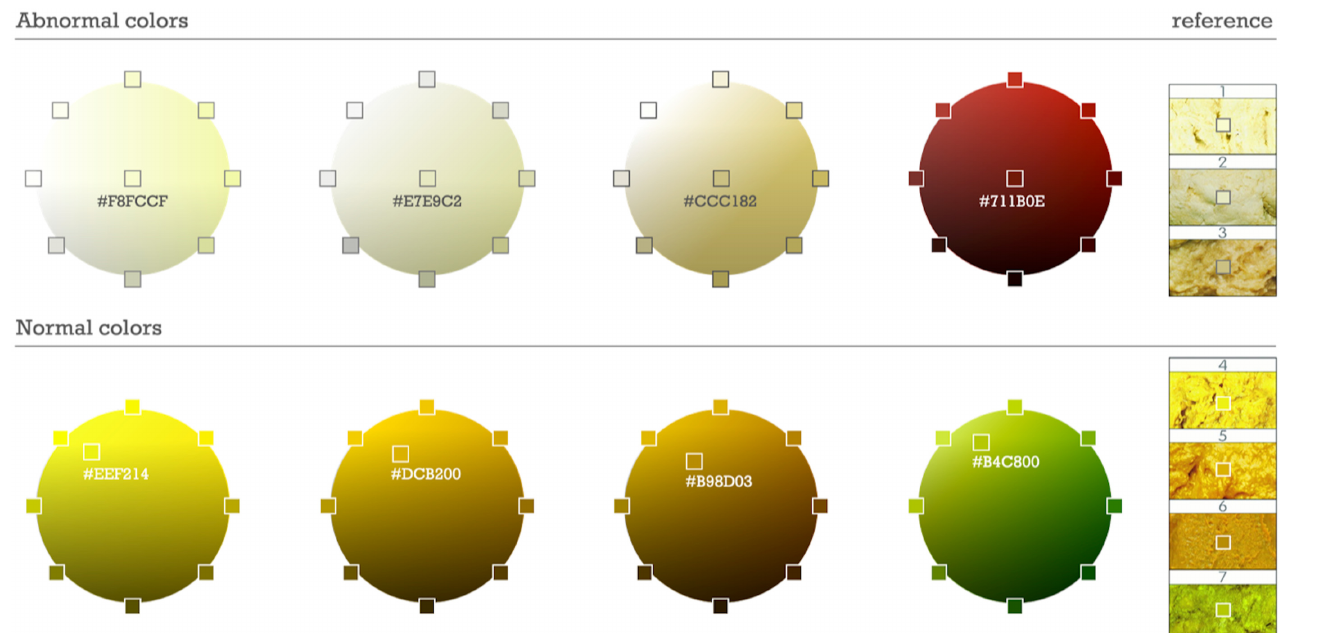
Fig 1. RGB hexcodes denoting the spectrum of abnormal and normal stool colors.